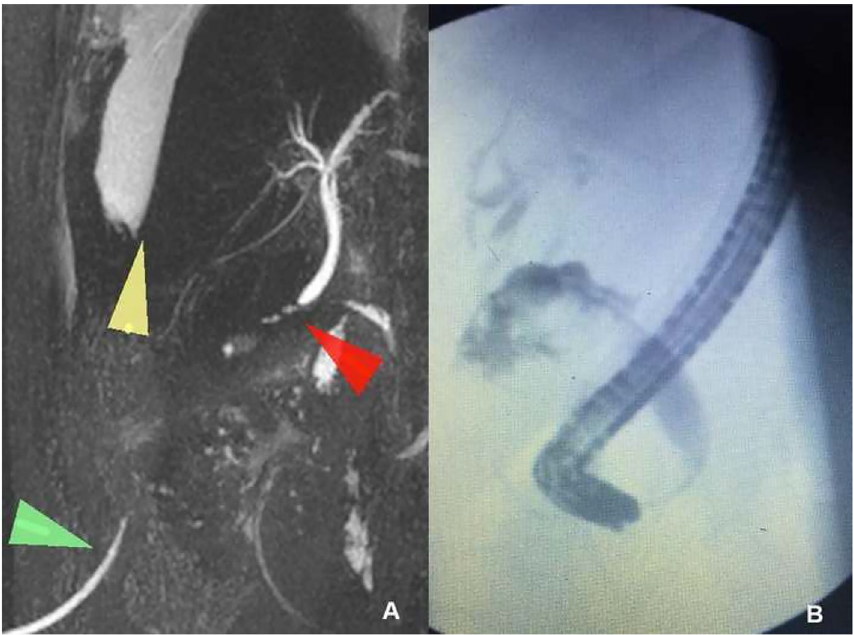
Fig. 4 3D-MRCP ( a ) post-cholecystectomy showing interrupted extra-hepatic biliary tree 3 cm distal to the biliary carina with traces of fluid signal at its lower end, representing biliary leak “red arrowhead”. Subcapsular collection is noted related to the right hepatic lobe “yellow arrowhead”. Percutaneous drainage catheter is noted “green arrowhead”. Strasberg Type E1; Bismuth-Corlette Type 1 bile duct injury. ERCP image ( b ) shows an abrupt cutoff of the extrahepatic bile duct with contrast material extravasation indicative of bile leakage